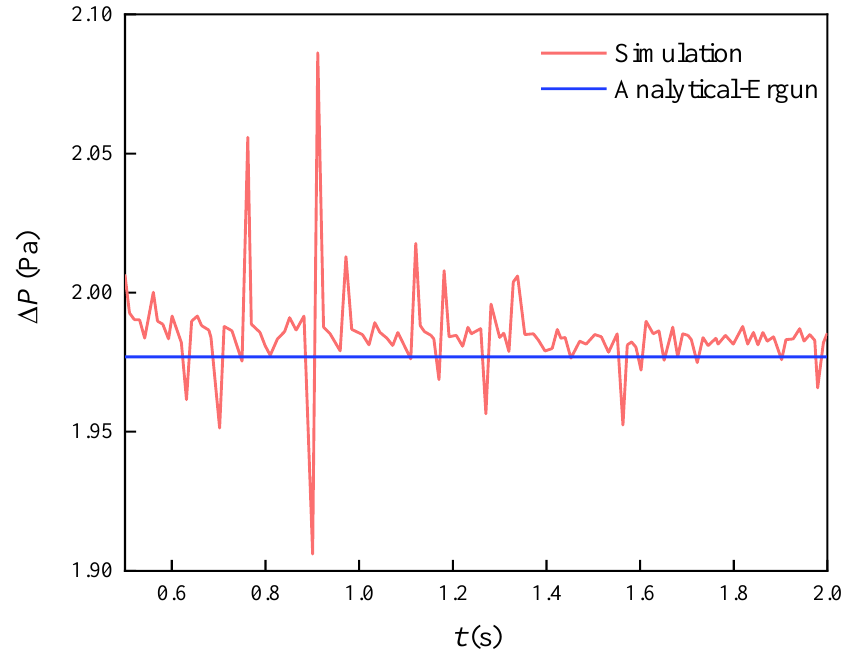
Figure 7. Comparison of pressure drop with time from simulations and the Ergun equation at u f = 0.68 m/s.